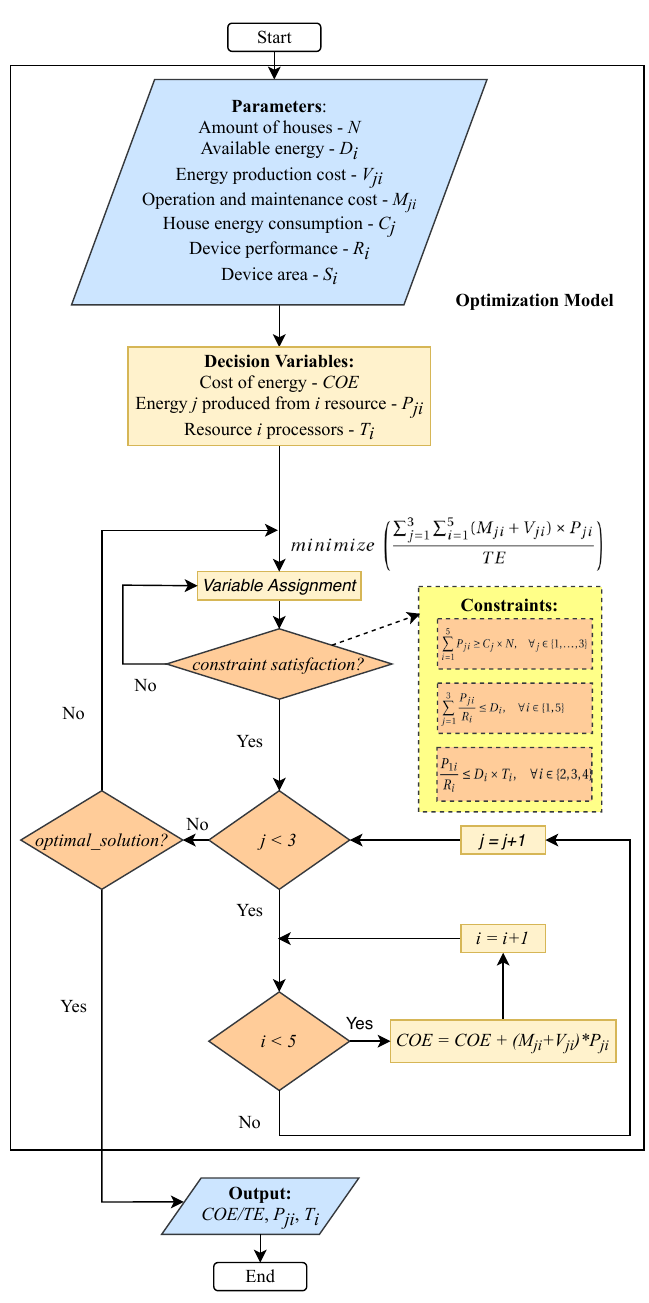
Figure 2. Graphical representation of the optimization